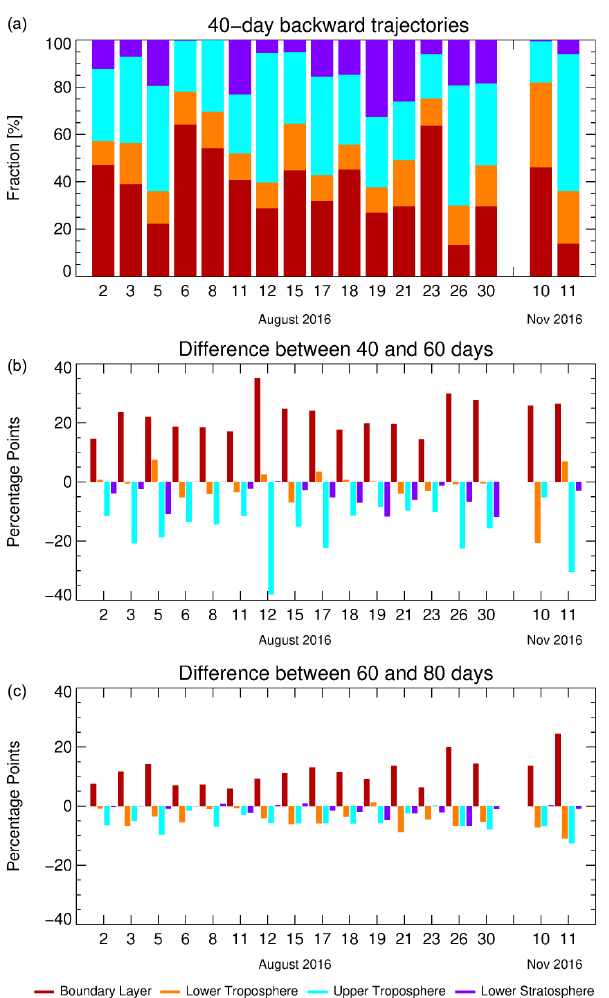
Figure 13. (a) The fractions of the different atmospheric altitude layers (BL, LT, UT, LS) for all flights in August and November 2016 normalised by the total number of trajectories of each day calculated from 40-day backward trajectories (see Table 2), (b) the difference between 40- and 60-day backward trajectory calculations and (c) between 60 and 80d.